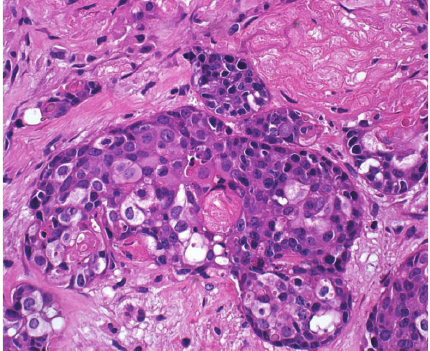
Figure 4: In addition to basaloid and shadow cells, transitional cells with eosinophilic to clear cytoplasm were seen in some cell clusters (hematoxylin and